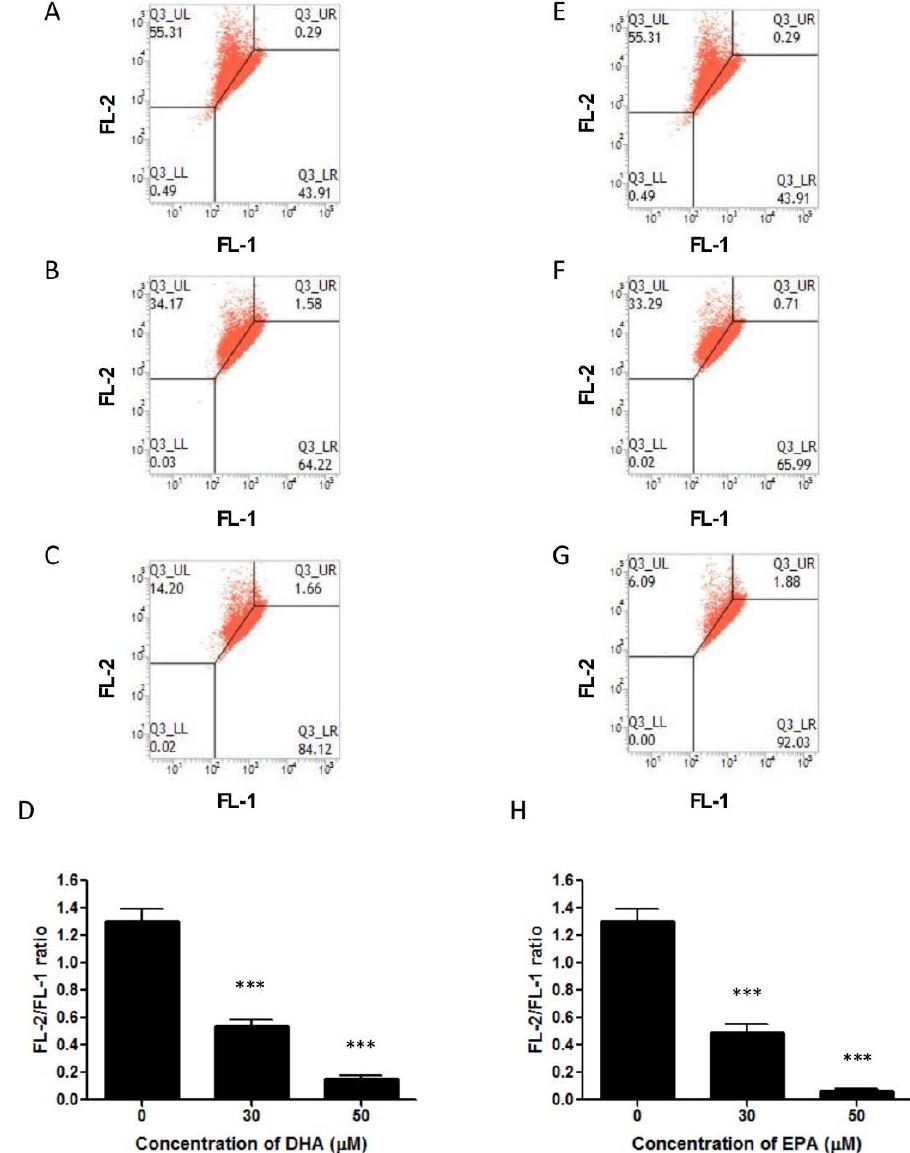
Figure 5. DHA and EPA reduce mitochondrial membrane potential in LA-N-1 cells. ( A – D ) LA-N-1 cells were incubated with ethanol control ( A ), 30 or 50 µM DHA ( B , C ) for 48 hours. (E – H) LA-N-1 cells were incubated with ethanol control ( E ), 30 or 50 µM EPA ( F , G ) for 48 hours. After incubation, the cells were stained by JC-1 dye and the mitochondrial potentials were detected by flow cytometry. The results are quantified and expressed as mean values ± SD ( D , H ). *** p < 0.001.